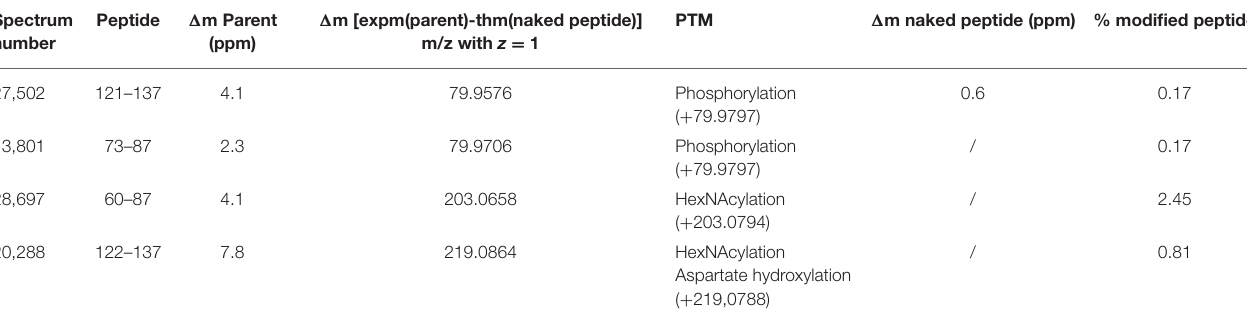
TABLE 3 | Manual analysis of PTMs raw data obtained for spot 11 from M14